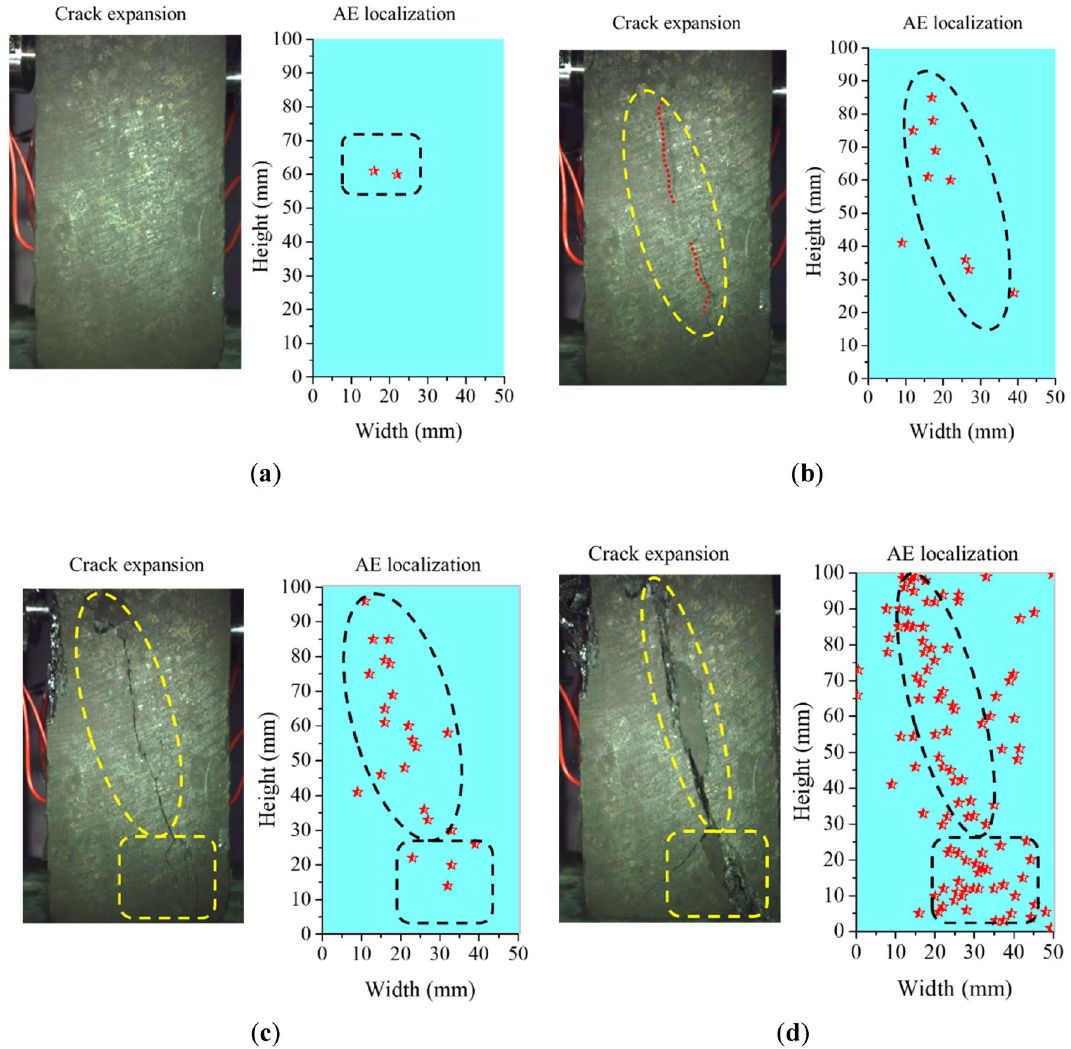
Figure 13. Results comparation between fracture events location and crack expansion before the failure of gas- bearing coal under load. ( a ) 100.1 s (37.1% maximum stress). ( b ) 299.1 s (80.3% maximum stress). ( c ) 359.6 s (93.7% maximum stress). ( d ) 396.9 s (100% maximum